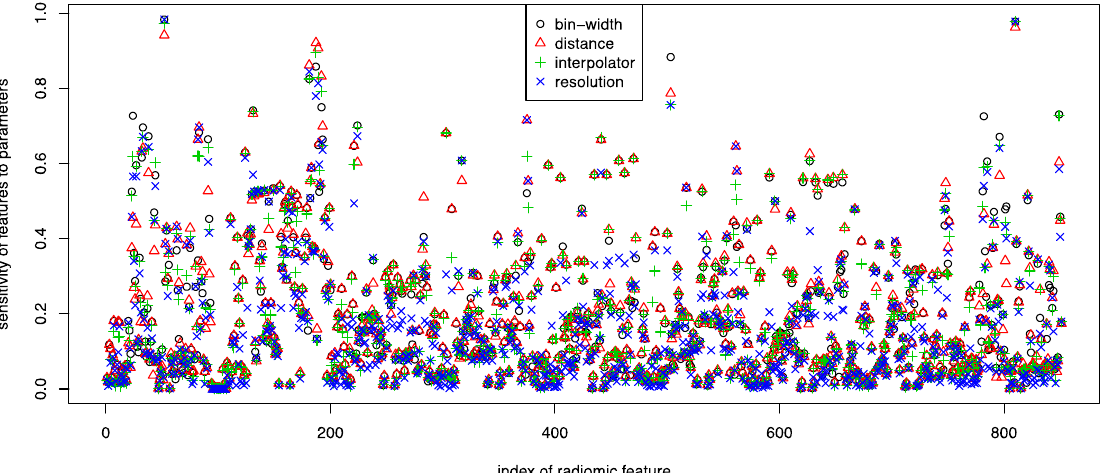
Figure 15. Sensitivity to other parameters. Per each feature, the range of variation of ICC is reported per each parameter (bin-width, pixel distance, interpolator and isotropic resolution) having fixed the other three.